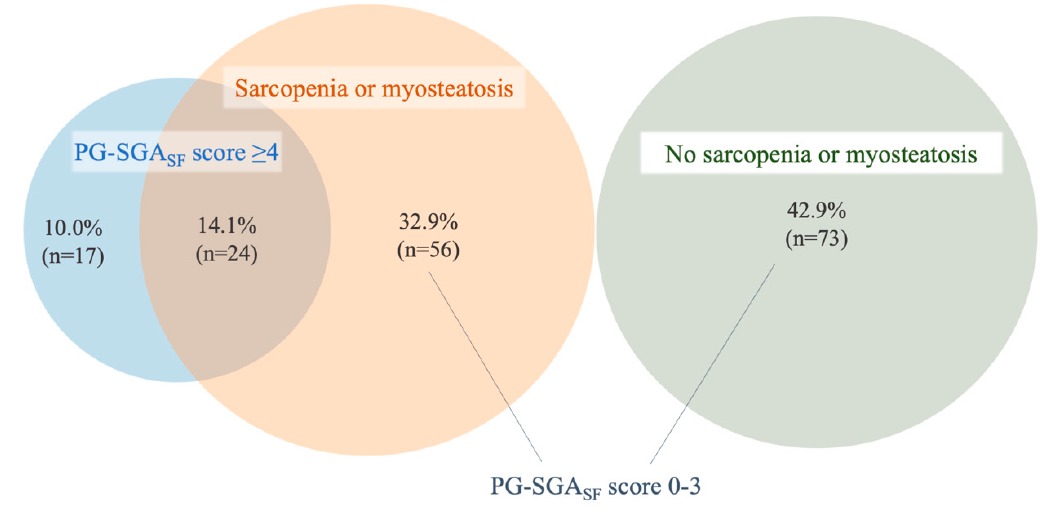
Table 4. Prevalence of sarcopenia and myosteatosis by PG-SGA SF score.